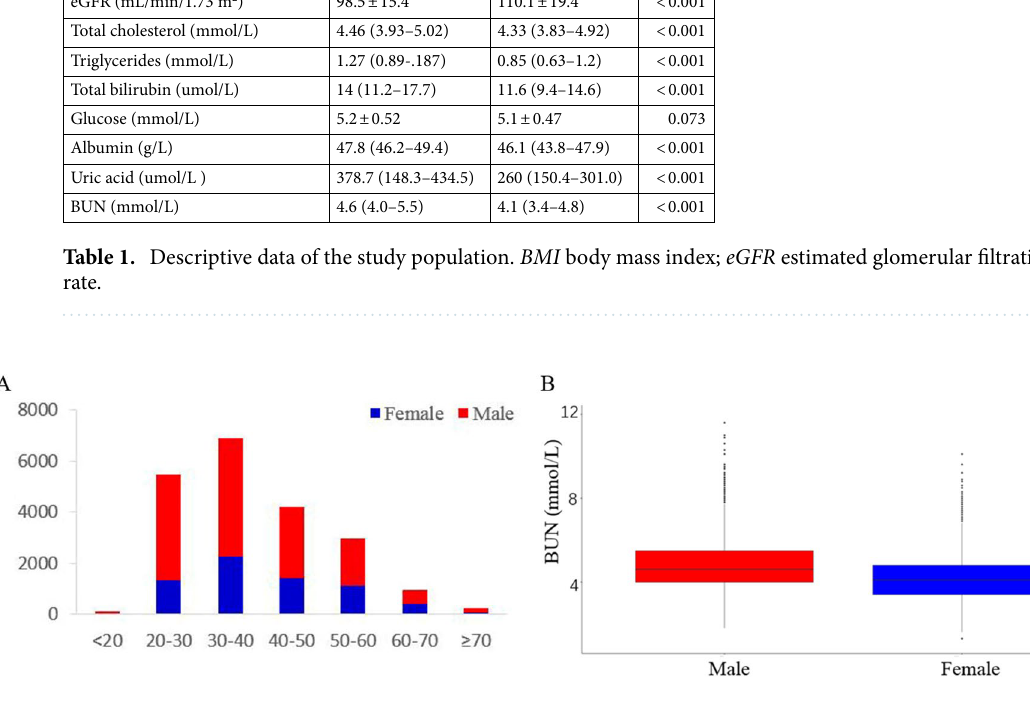
Figure 1. ( A ) Histogram for age and gender distribution of the BUN reference in males and females population. ( B ) Baseline BUN in males and females population. The box represents IQRs, the horizontal line in each box represents the median and the whiskers show the 10–90 percentile